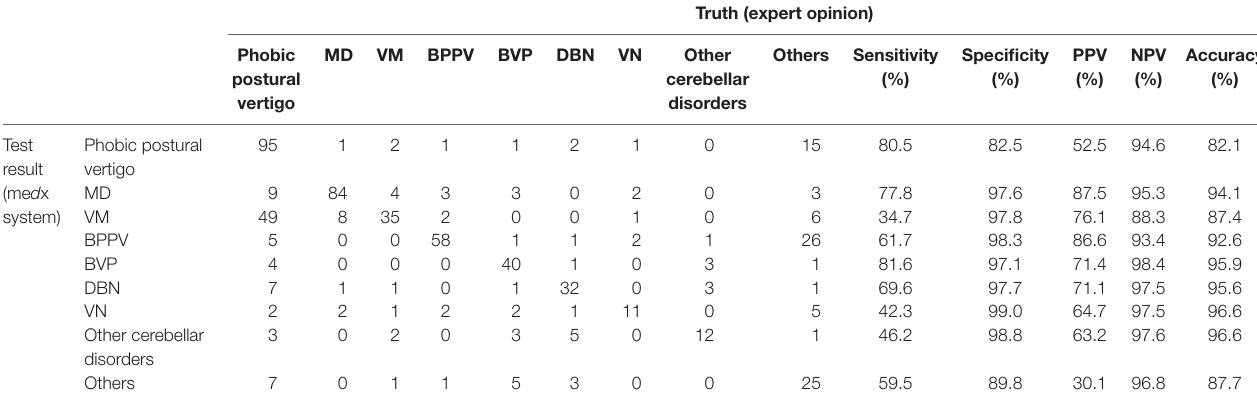
TaBle 3 | Comparison of the classification of me d x system and the truth as a multiclass problem for the six most prevalent diagnoses.